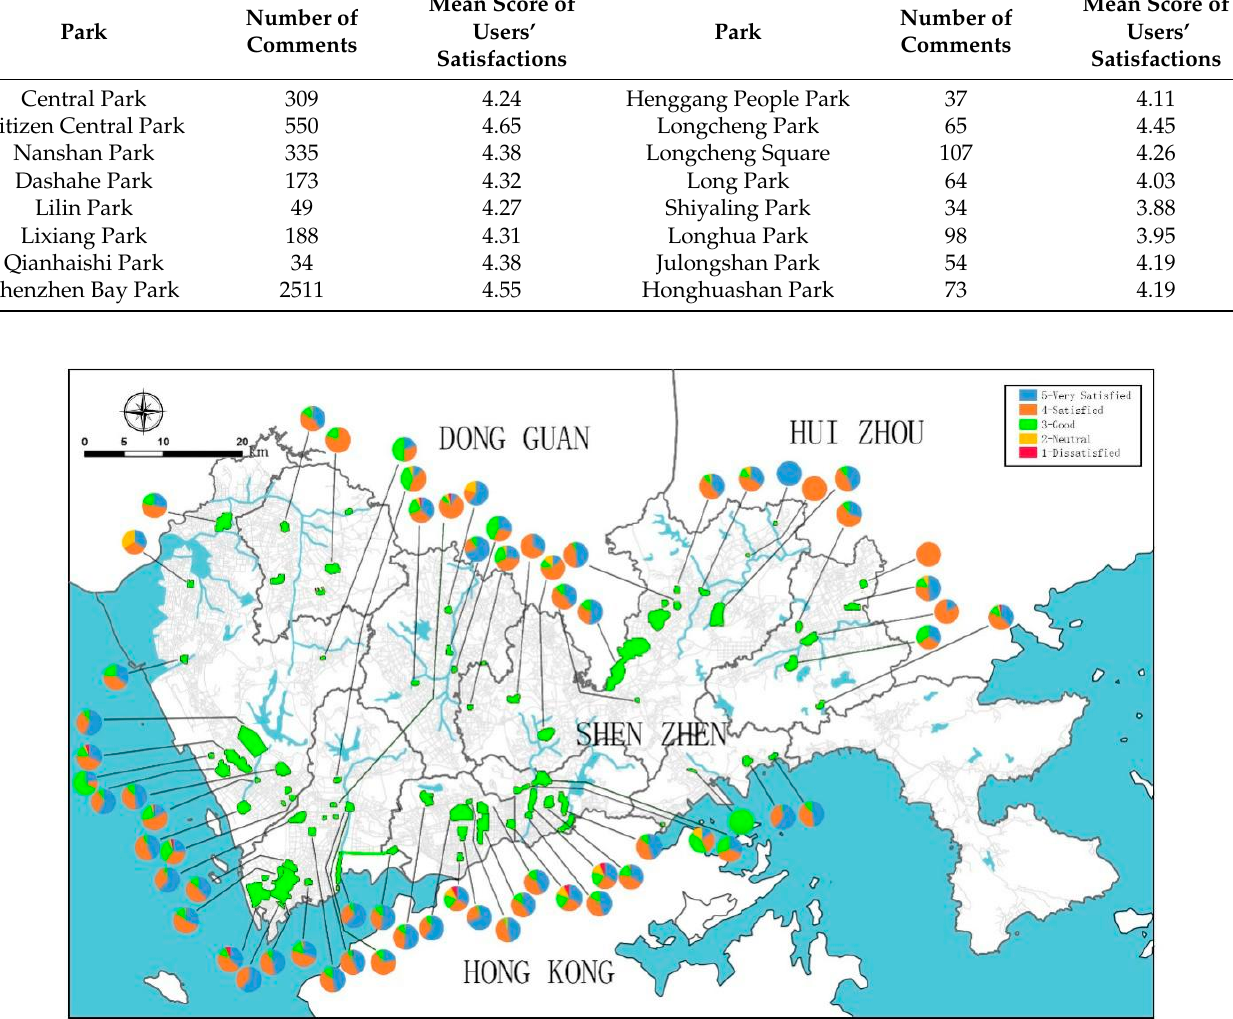
Figure 4. The proportion of dissatisfied, neutral, good, satisfied, and very satisfied users’ satisfactions received per comprehensive park (drawn by the authors).